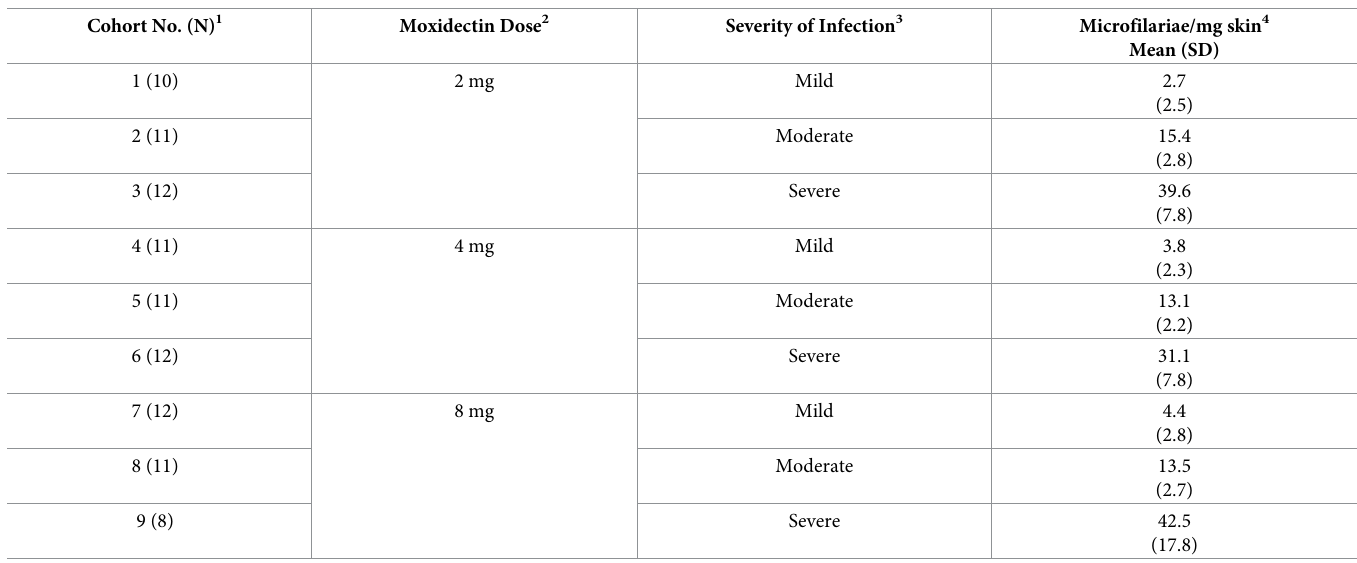
Table 1. Moxidectin dose and severity of infection by